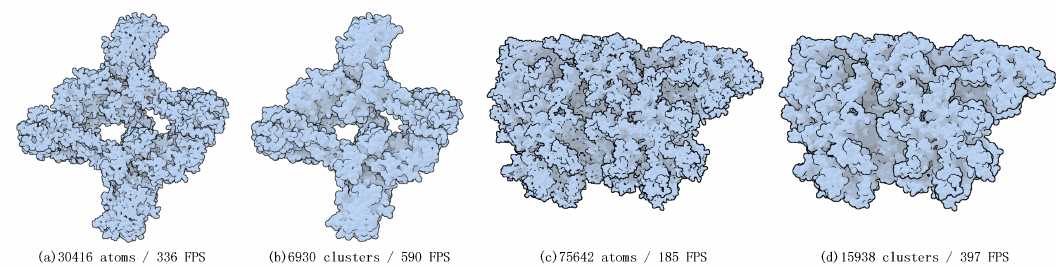
Figure 1. Two molecular examples, a transferase protein and a viral protein, demonstrating utilization of our ellipsoidal abstract representations ( b , d ). In the presented examples we achieved 1 × to 2 × speed-up as compared to the full vdw representation ( a , c